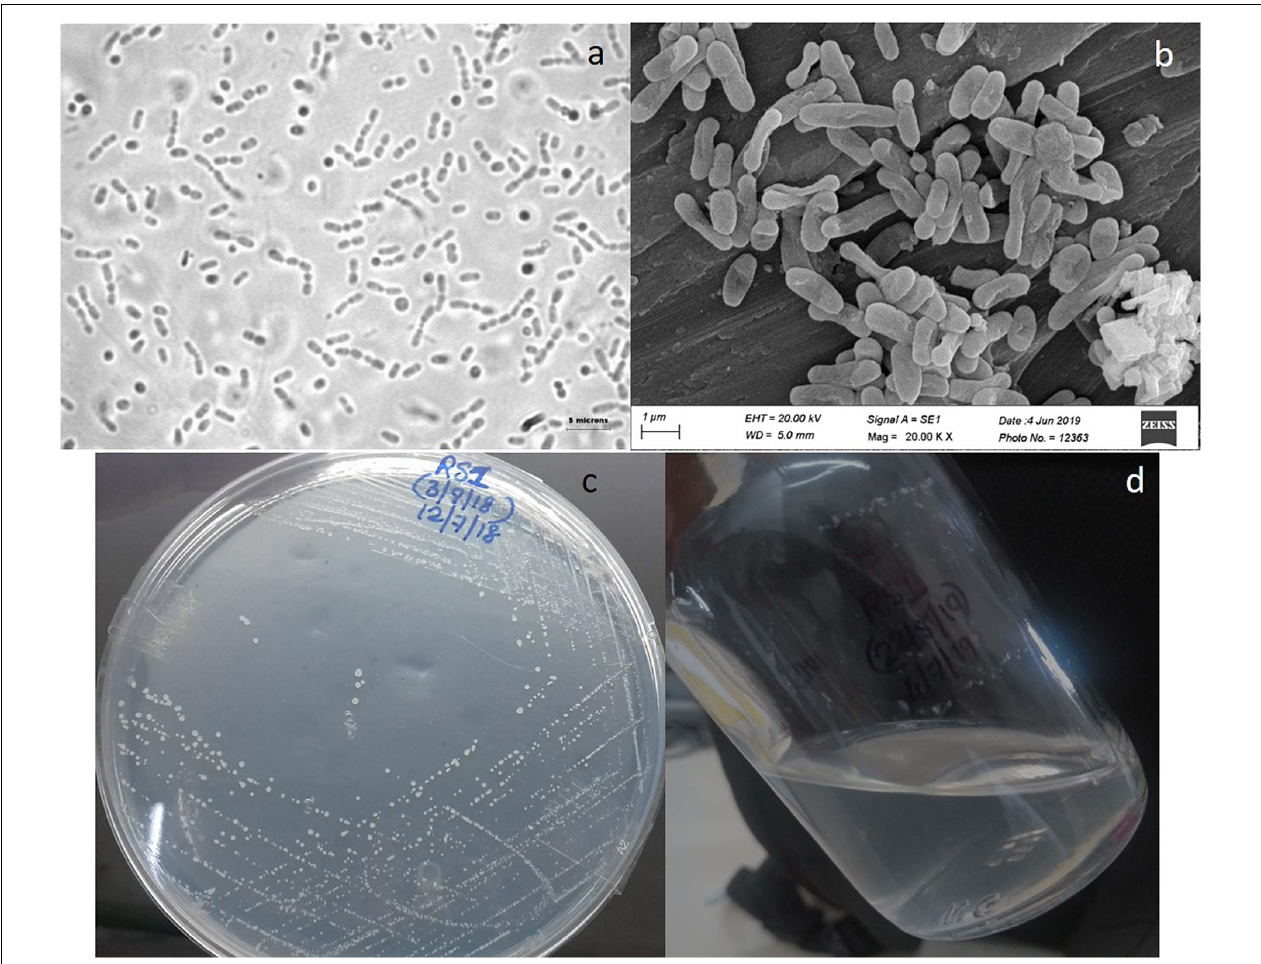
FIGURE 4 | Morphology of strain RS1: (a) live cells were observed under a phase-contrast microscope (Nikon 80i, Japan microscope with a camera) under 100 × magnification with oil emulsion. (b) Culture observed under a scanning electron microscopy (SEM) (Zeiss model EVO-MA-15 SEM). (c) Colony morphology on solid nitrate mineral salts (NMS) medium. (d) RS1 forms whitish turbid suspension growth in liquid NMS medium.